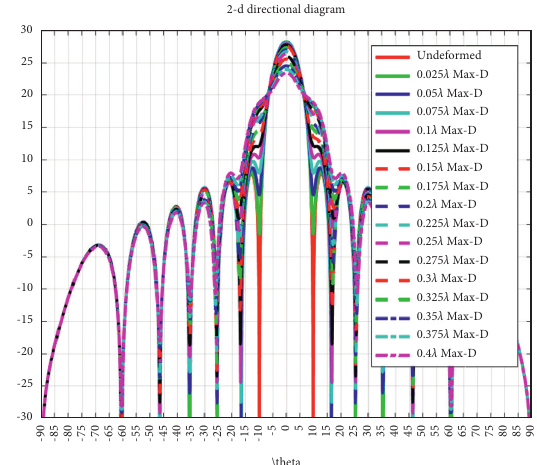
Figure 18: Azimuth plane of saddle-shaped